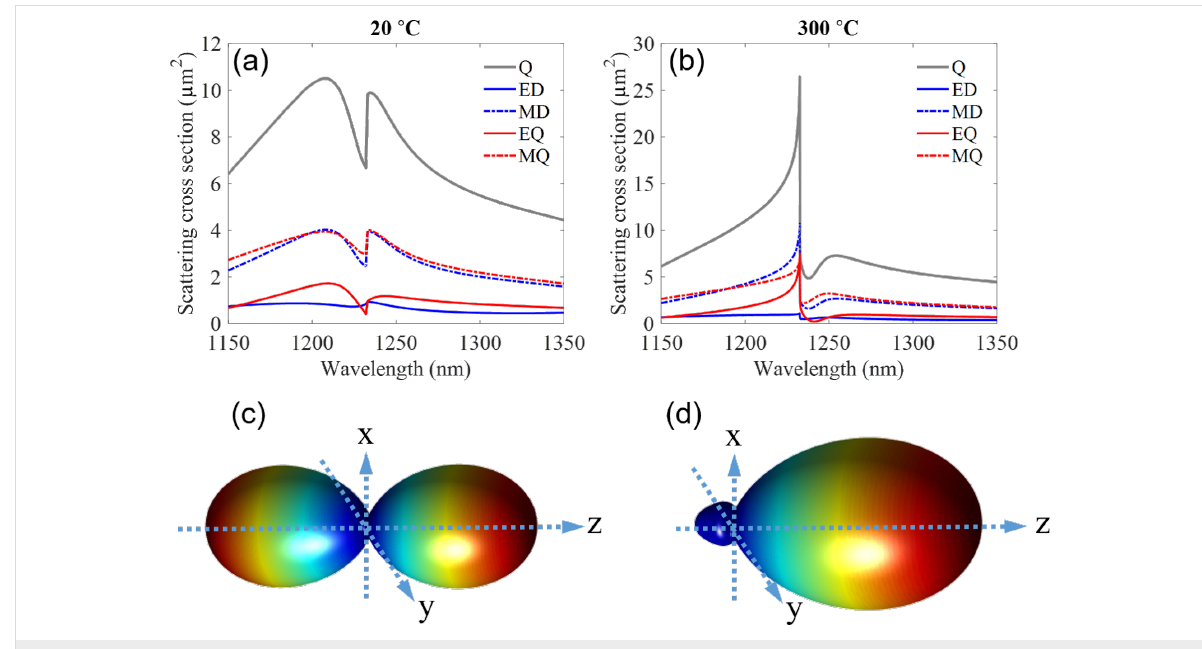
Figure 3: Scattering cross section (a) before and (b) after heating, including zoomed in on Kerker condition in the heated scattering cross section sample. Far-field radiation pattern (c) before and (d) after heating.